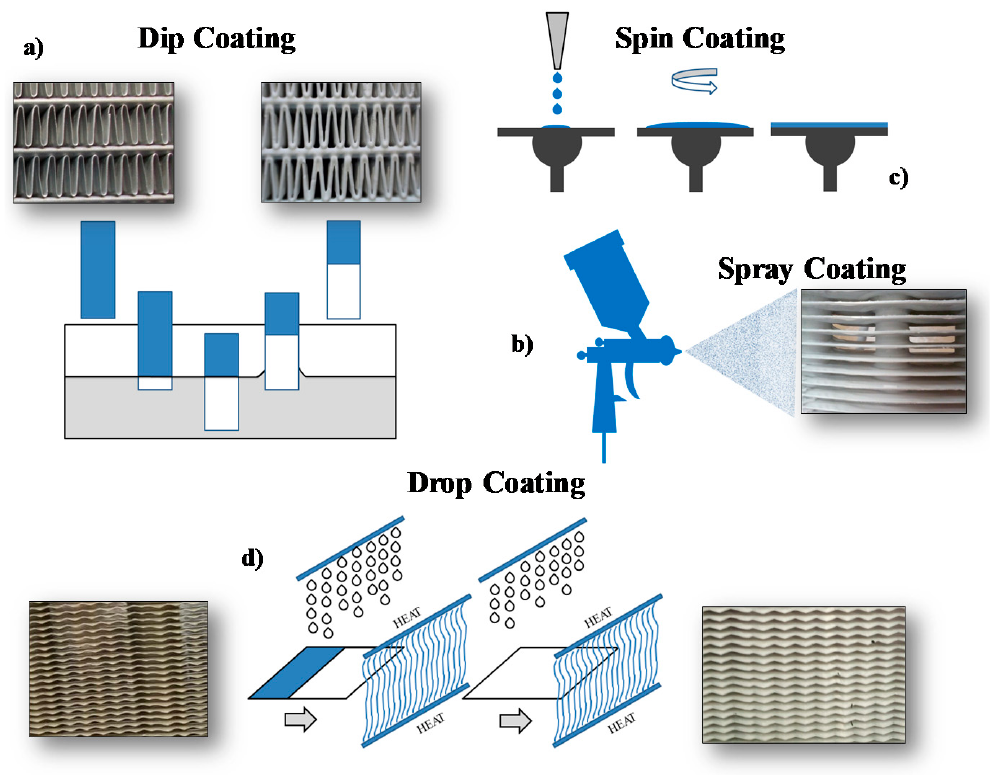
Figure 6. Binder based coatings production techniques, dip-coating ( a ), spray-coating ( b ) spin-coating ( c ) and drop-coating ( d ).